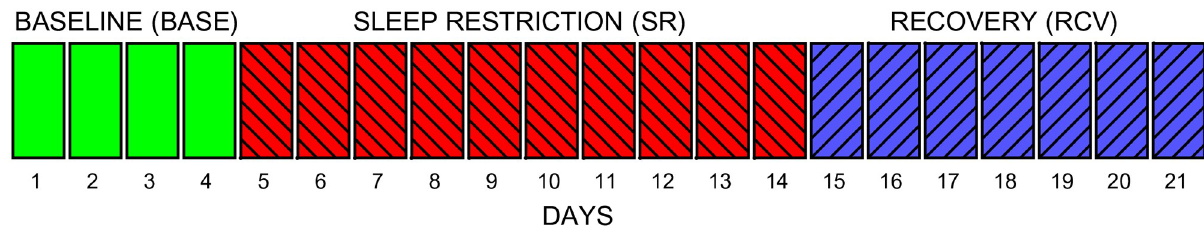
Fig 1. Study experimental design, showing number of days in each of the experimental sleep